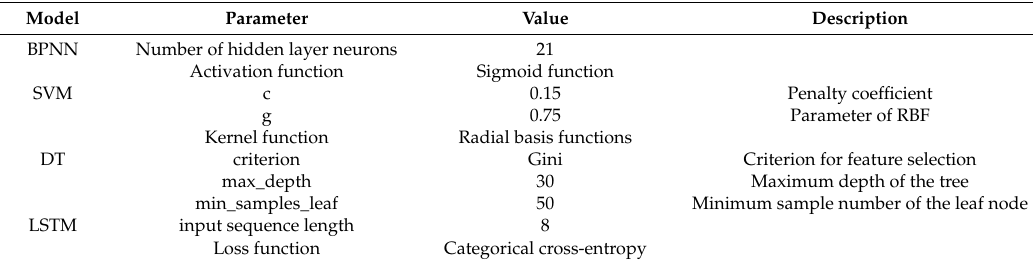
Table 1. Optimal parameters of different